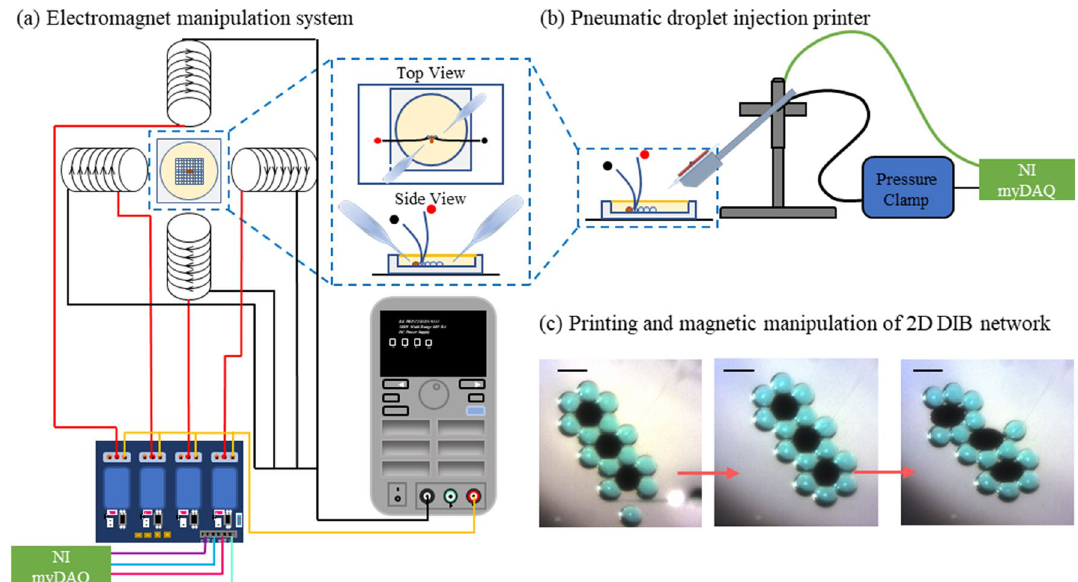
Figure 2. Schematic representation of the magnetic stage: the pneumatic microdroplet printer and the electromagnet array. ( a ) Four solenoids with paramagnetic cores (EFI alloy) are placed as shown and used to magnetically control the position of ferrofluid droplets injected into the oil medium. The power input of the solenoids is computer controlled with a user interface connected to an external microcontroller (ARDUINO), a relay system and a power supply. ( b ) Microdroplets are deposited into the oil dish using a computer-controlled pneumatic system. Microinjectors are pressurized using a pressure-clamp system connected to an external microcontroller (ARDUINO). These schematic representations were created by the authors using Microsoft PowerPoint. ( c ) Various compositions of DIB structures can be constructed by depositing magnetic (EMG 507—black color) and non-magnetic (aqueous buffer—blue color) microdroplets into an oil medium. Droplets are then brought into contact using a user-driven micropipette; interfacial bilayers are formed giving rise to a stable 2D membranous structure. Scale bars represent 600 µm